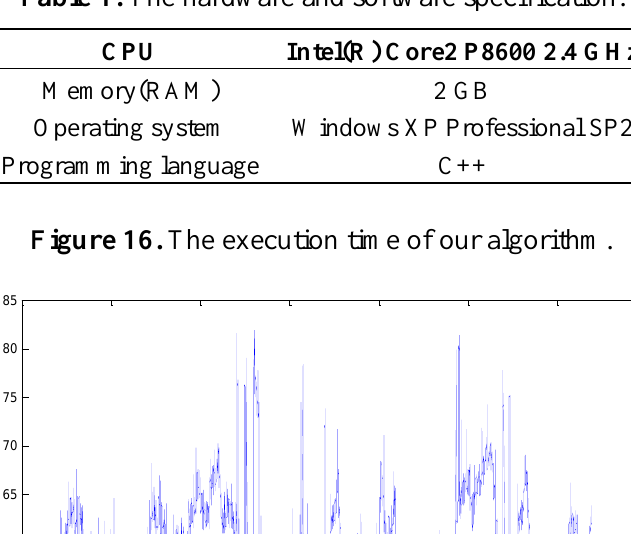
Table 1. The hardware and software specification.